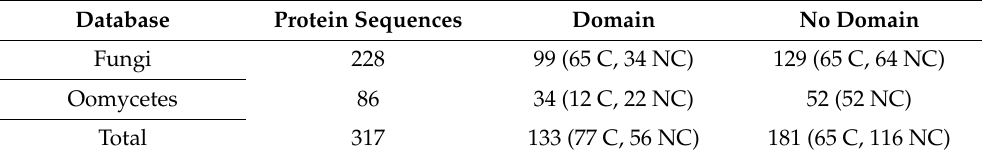
Table 5. Classification of fungal and oomycete effectors with respect to functional domains